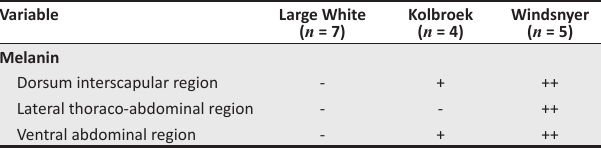
FIGURE 3: Representative skin sections (a, b, c) from the dorsal interscapular region (d, e, f), lateral thoraco-abdominal region and (g, h, i) ventral abdominal region of (a, d, g) Windsnyer (b, e, h), Kolbroek and (c, f, g) Large White pigs. The figure shows a large amount of melanin pigments in the basal layer of the epidermis in the Windsnyer pigs, very little in the interscapular region in the Kolbroek pigs and no melanin pigments in Large White pigs (Fontana staining; objective: 20×). TABLE 3: A comparison of the presence of melanin in the basal layers of the skins of the local Kolbroek and Windsnyer pigs and the exotic Large White pigs.